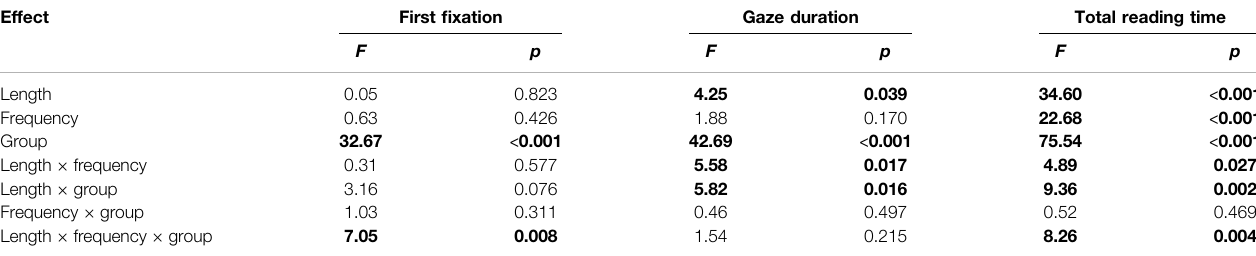
TABLE3| F -testsand p -valuesforthemaineffectsandinteractionsofwordlength,frequencyandgroupinthreeeyemovementmeasures(numbersmarkedinboldindicate signi fi cant effects). Effect First fi